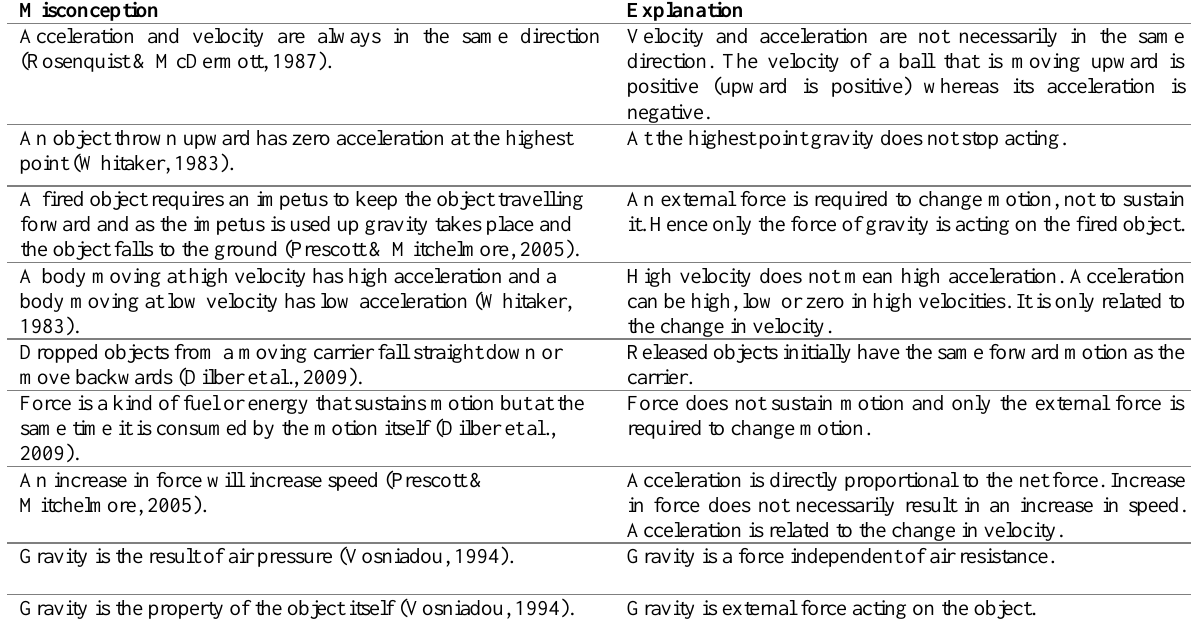
Table 2: Some of the Misconceptions in Projectile